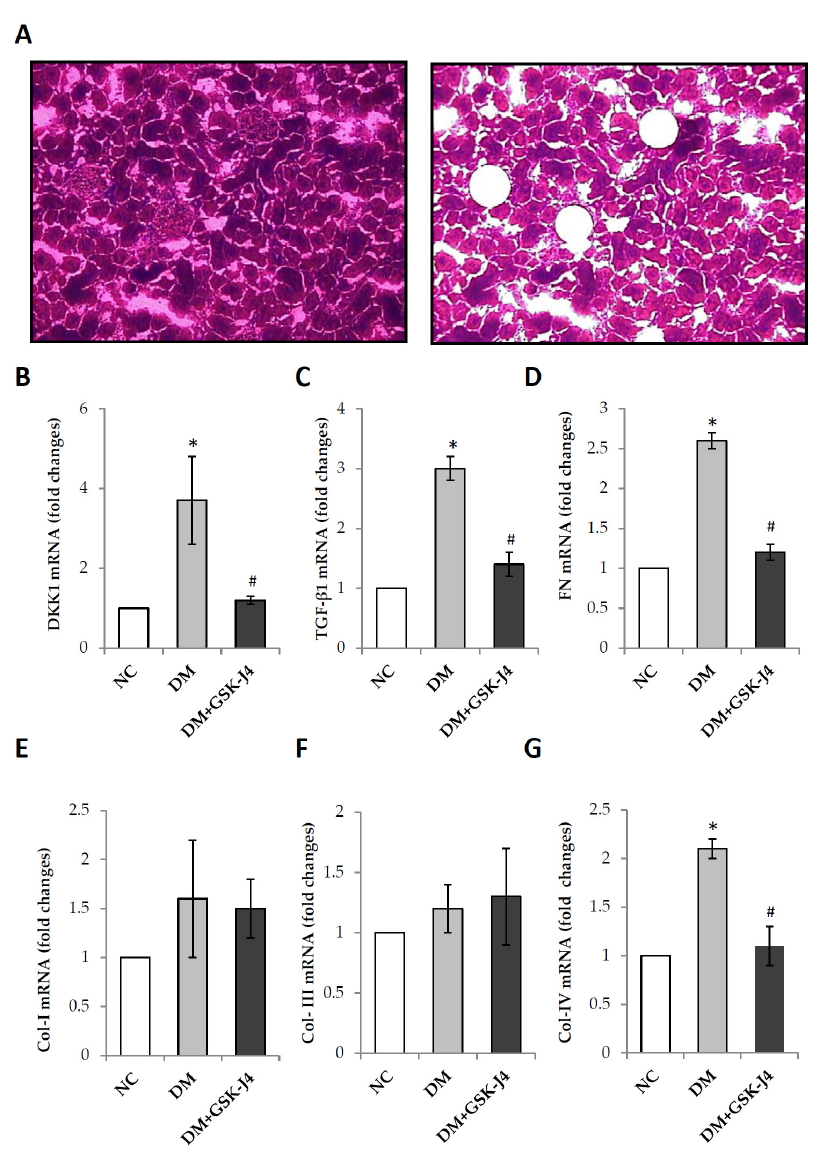
Figure 5. The mRNA expression levels of profibrotic genes in the glomerular of STZ-induced diabetic mice after laser capture microdissection (LCM). For the experiment, the mice were divided into three groups: (i) normal mice (NC), (ii) STZ-induced diabetic mice (DM), and (iii) STZ-induced diabetic mice that were treated with GSK-J4 (DM + GSK-J4). ( A ) Laser capture microdissection of glomeruli in formalin-fixed paraffin-embedded kidney tissues. Before LCM ( left ); after LCM ( right ) . These samples were then separately collected for RNA and subjected to quantitative RT-PCR analysis for DKK1 (enlargement factor 10×). ( B ), TGF- β 1 ( C ), FN ( D ), Col-I ( E ), Col-III ( F ), and Col-IV ( G ). * p < 0.05 versus the control group; # p < 0.05 DM versus DM + GSK-J4. Data are mean ± standard errors calculated from six mice. Abbreviations: Col-I, collagen I; Col-III, collagen III; Col-IV, Collagen IV; DKK1, dickkopf-1; DM, STZ-induced diabetic mice; FN, fibronectin; NC, normal mice; and TGF- β 1, transforming growth factor β 1.